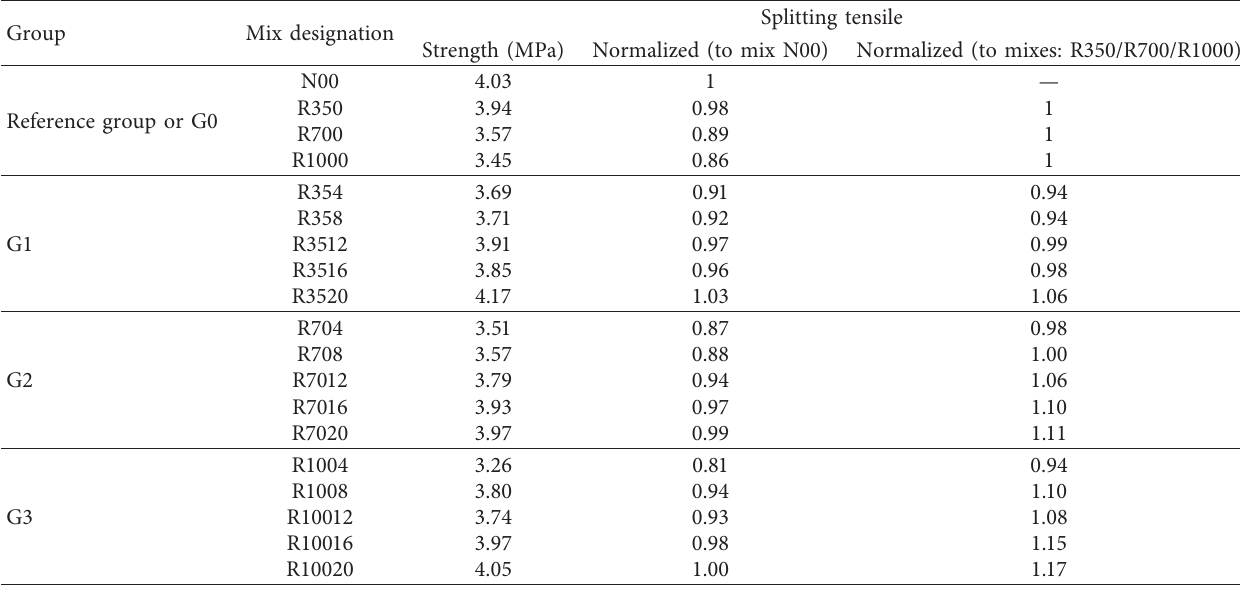
Splitting tensile Normalized (to mixes: R350/R700/R1000)